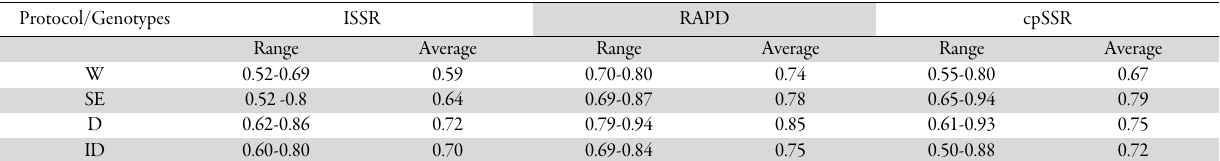
Table 6. Jaccard’s similarity coefficient range within studied plant groups (W= wild, SE=somatic embryogenesis, D= direct, ID= indirect organogenesis)